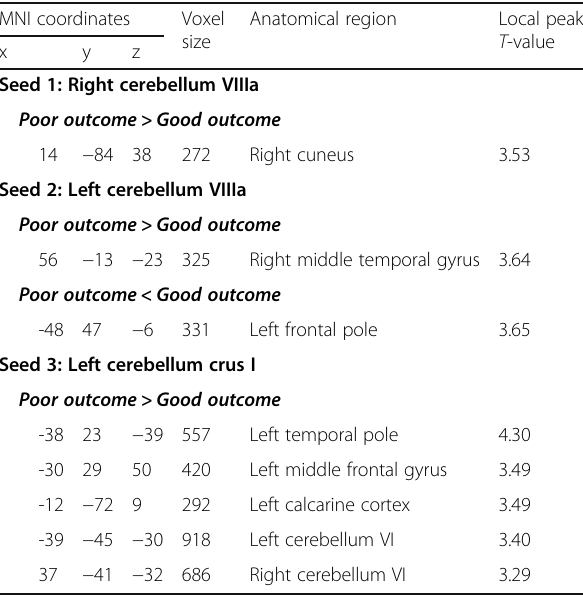
Table 3 Difference in structural covariance between patients with HFM with different